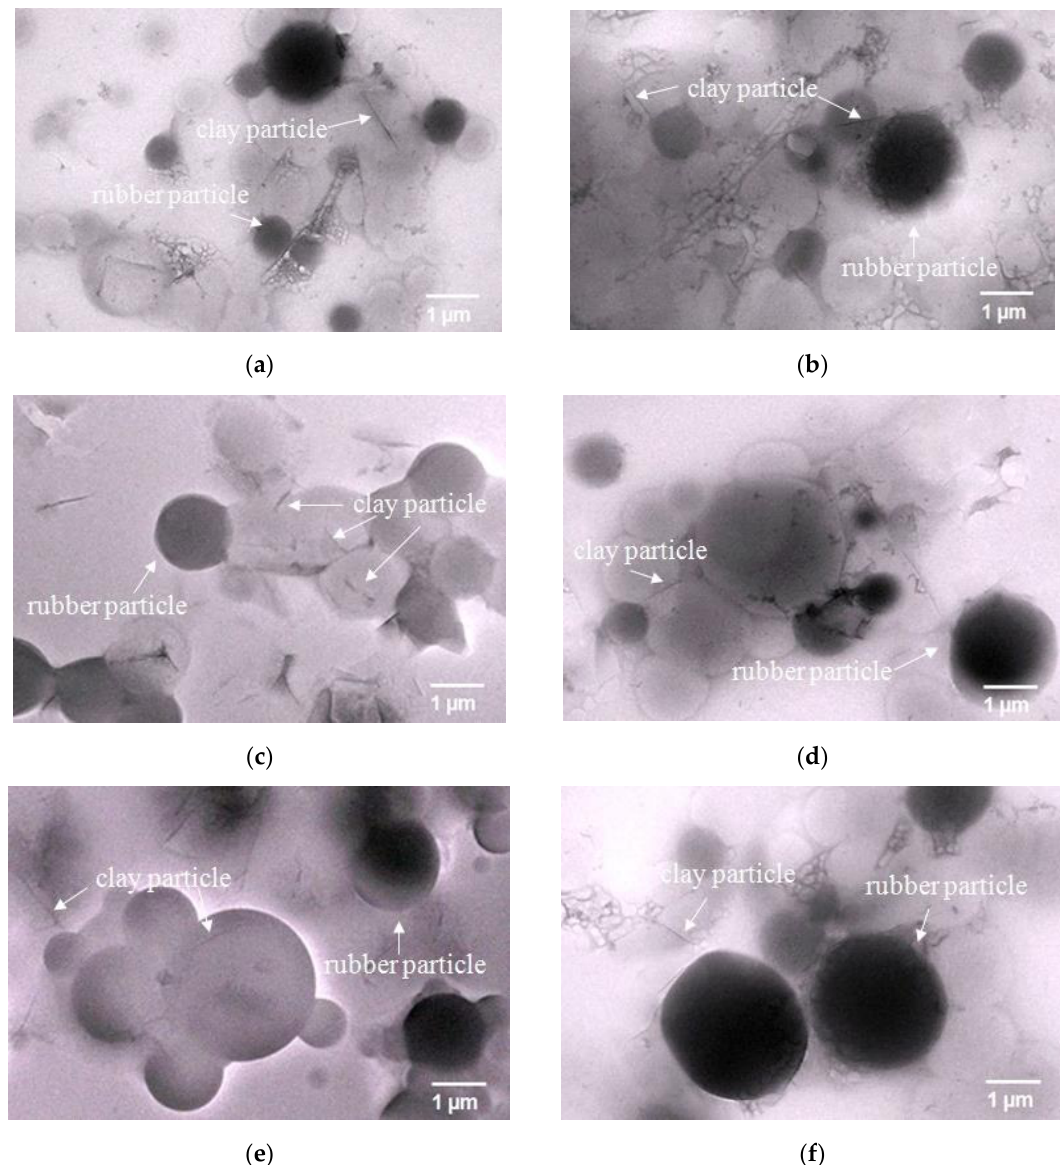
Figure 4. TEM images of nanoclay-modified isoprene latexes prepared through starve-fed emulsion (SFE) polymerization with the variation of nanoclay content: ( a ) 1 wt%; ( b ) 3 wt%; ( c ) 5 wt%; ( d ) 7 wt%; and ( e ) 10 wt% of nanoclay relative to the amount of monomer. The image ( f ) belongs to the latex prepared with batch emulsion (BE) system with 5 wt% of nanoclay relative to the monomer content.